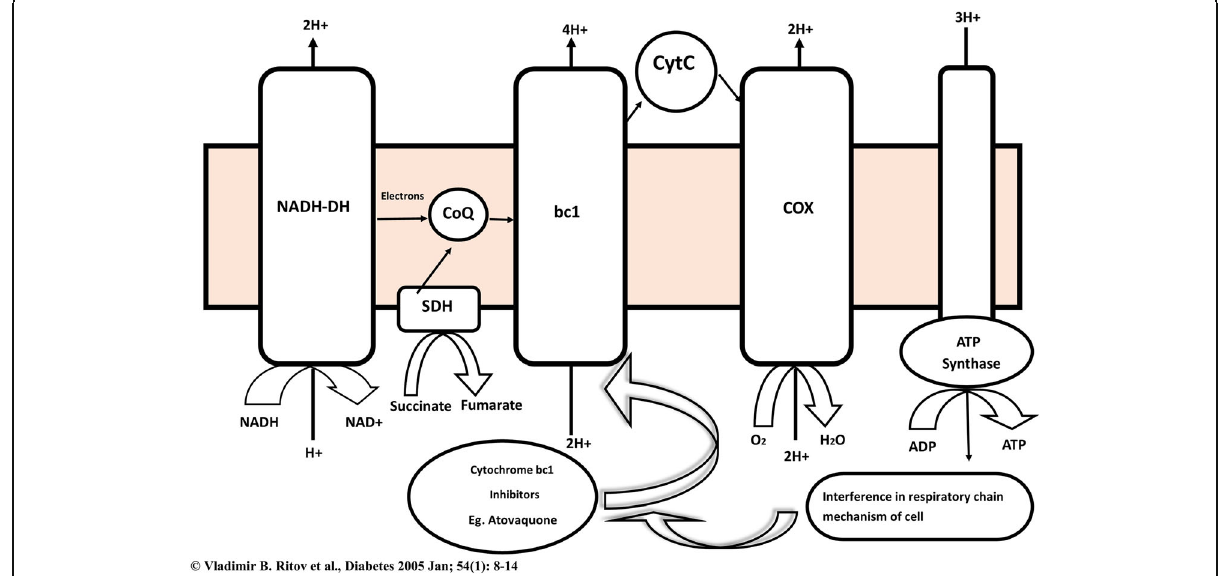
Fig. 12 Proposed mechanism for cytochrome bc1 inhibition which result in inhibition of ATP synthesis